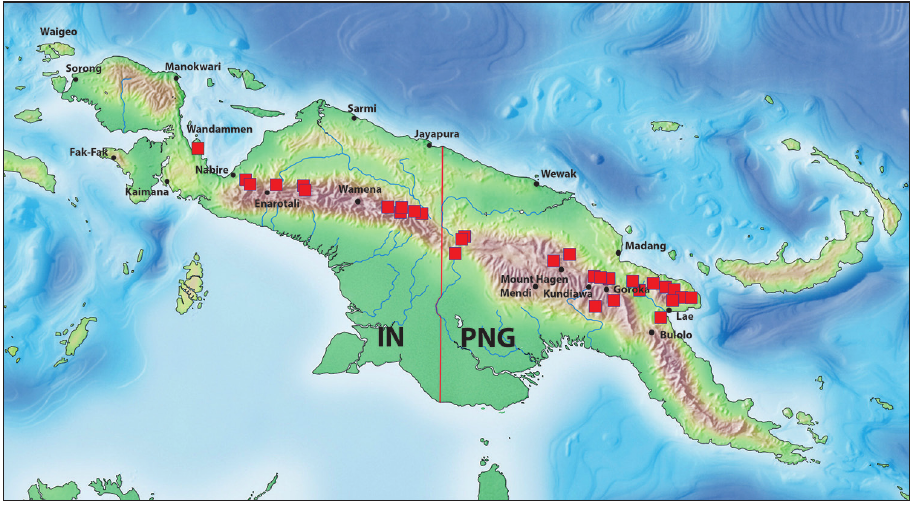
Figure 39. Map of New Guinea showing distribution of Exocelina damantiensis (Balke, 1998).